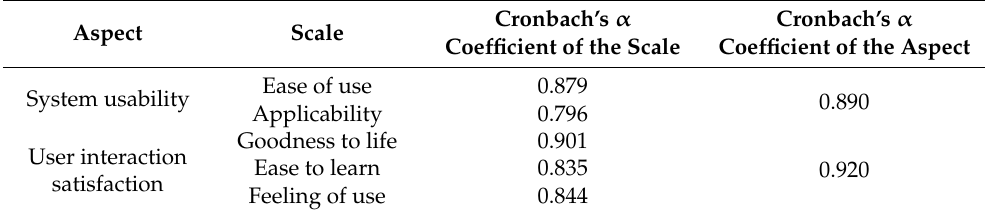
Table A8. The Cronbach’s α coefficients of the collected questionnaire survey data of the scales and aspects of the